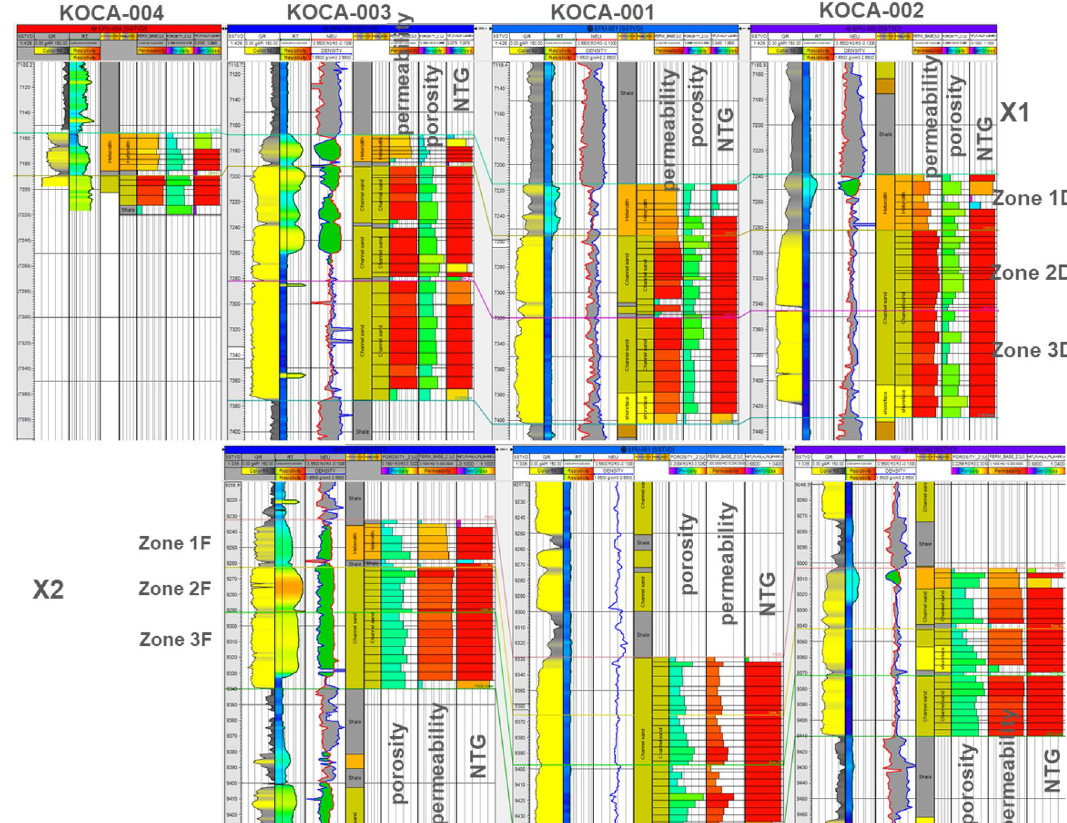
Fig. 14 Upscaled logs used to QC the zoning and layering of reservoir